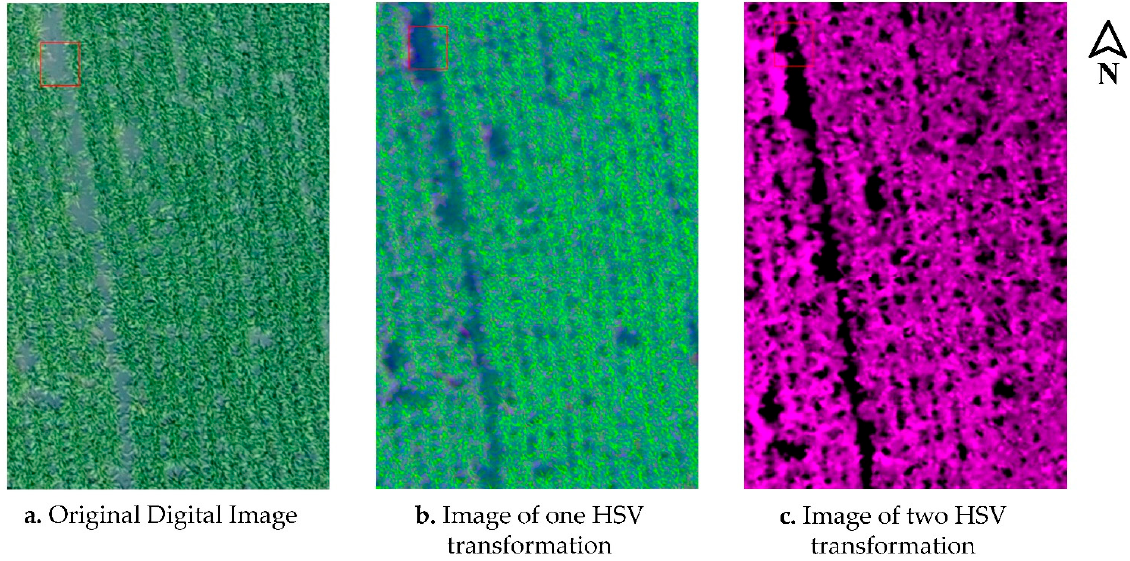
Figure 5. Process of two HSV Color Space transformation.